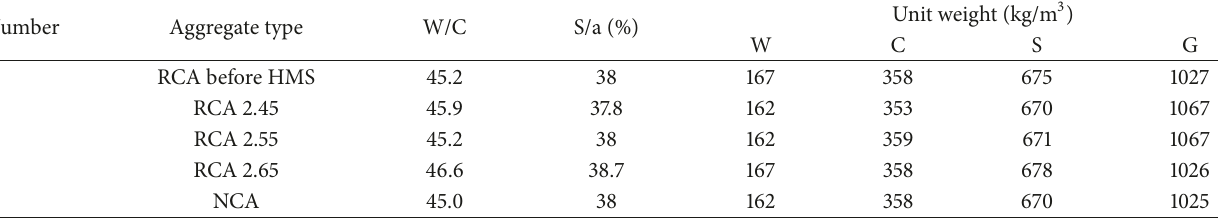
Table 3: Summary of mix proportions for compressive strength